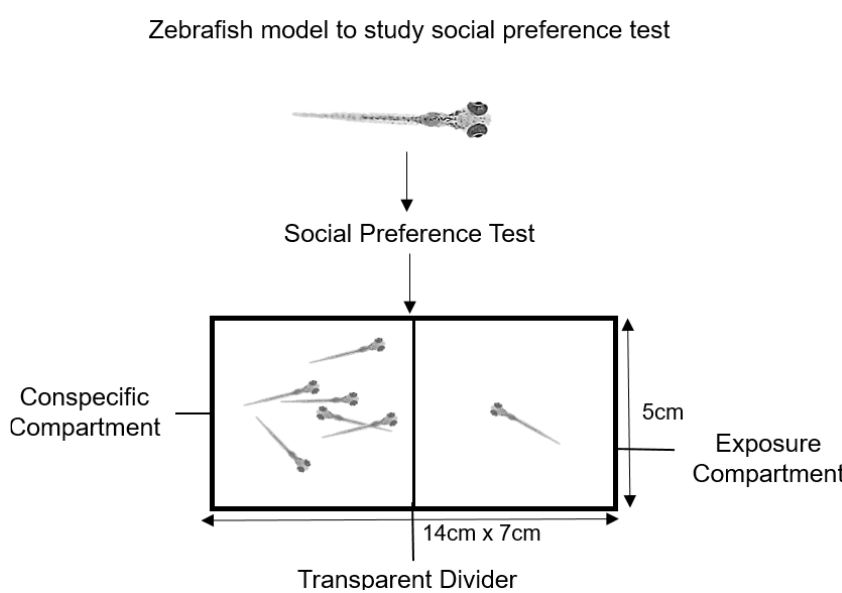
Figure A1. Social preference in zebrafish larvae.